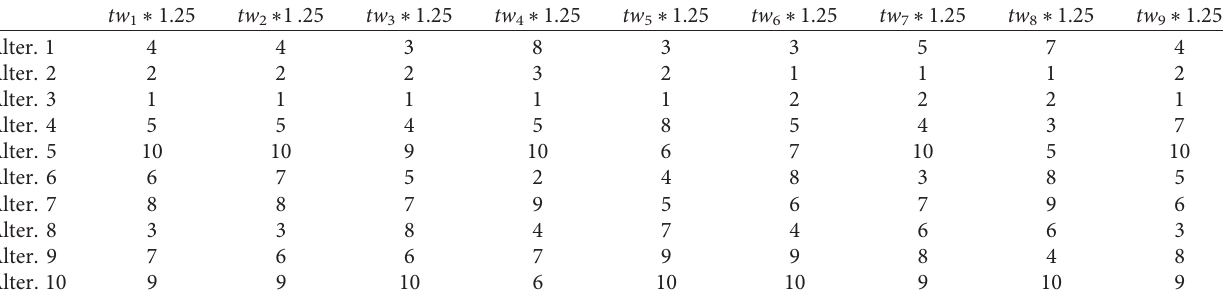
— — 1 Table 25: Scenarios for the sensitivity analysis (phase I, 25%).